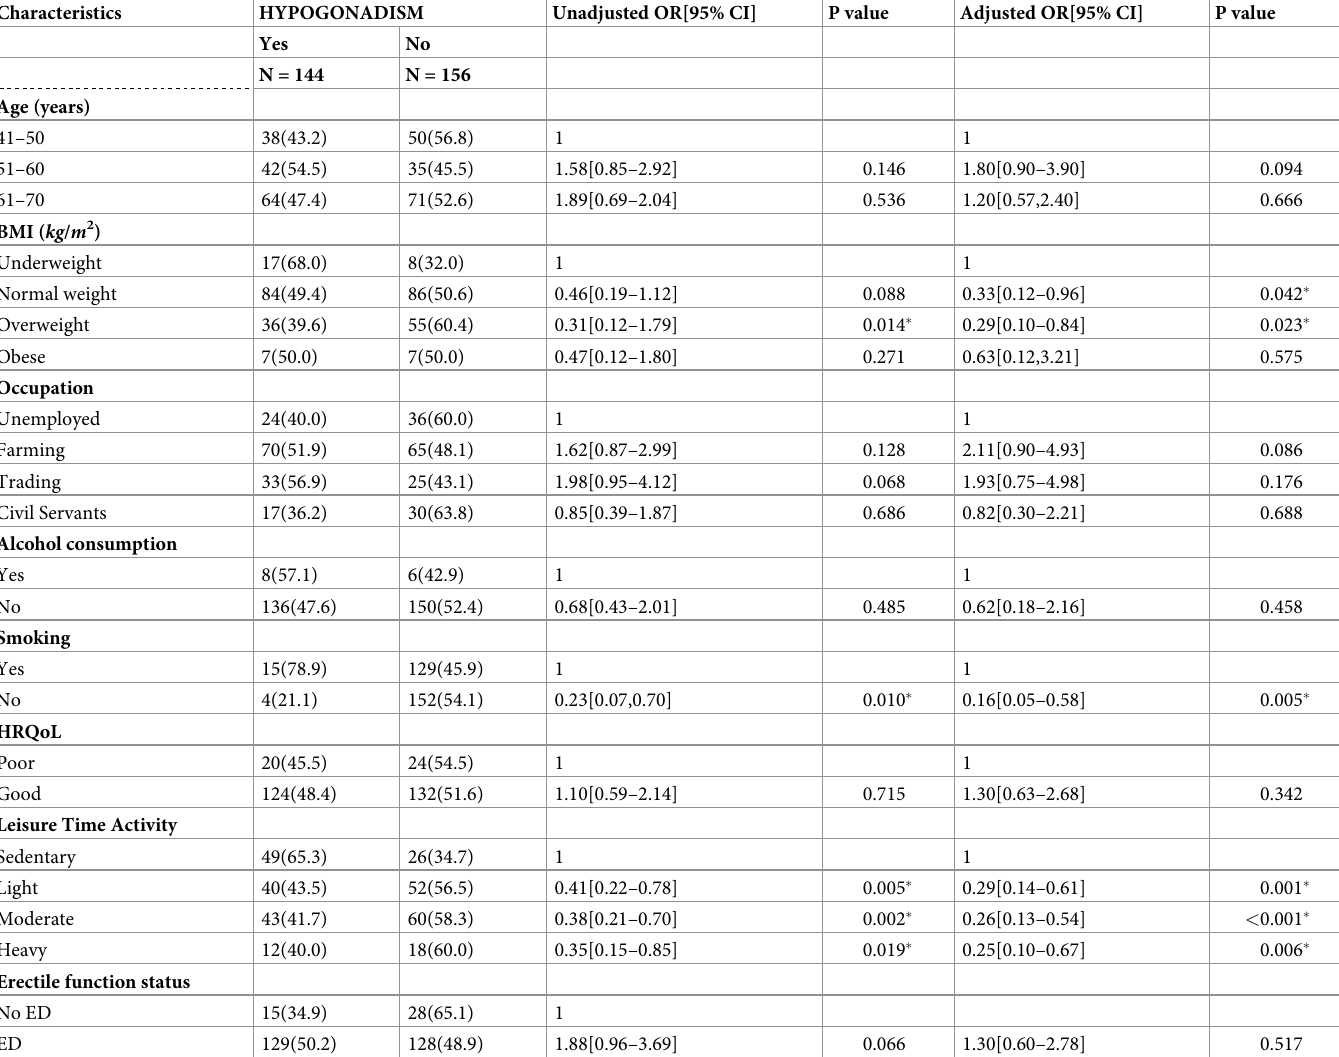
Table 4. Binary and multivariate logistic regression of sociodemographic, clinical and lifestyle factors associated of hypogonadism in the study participants.